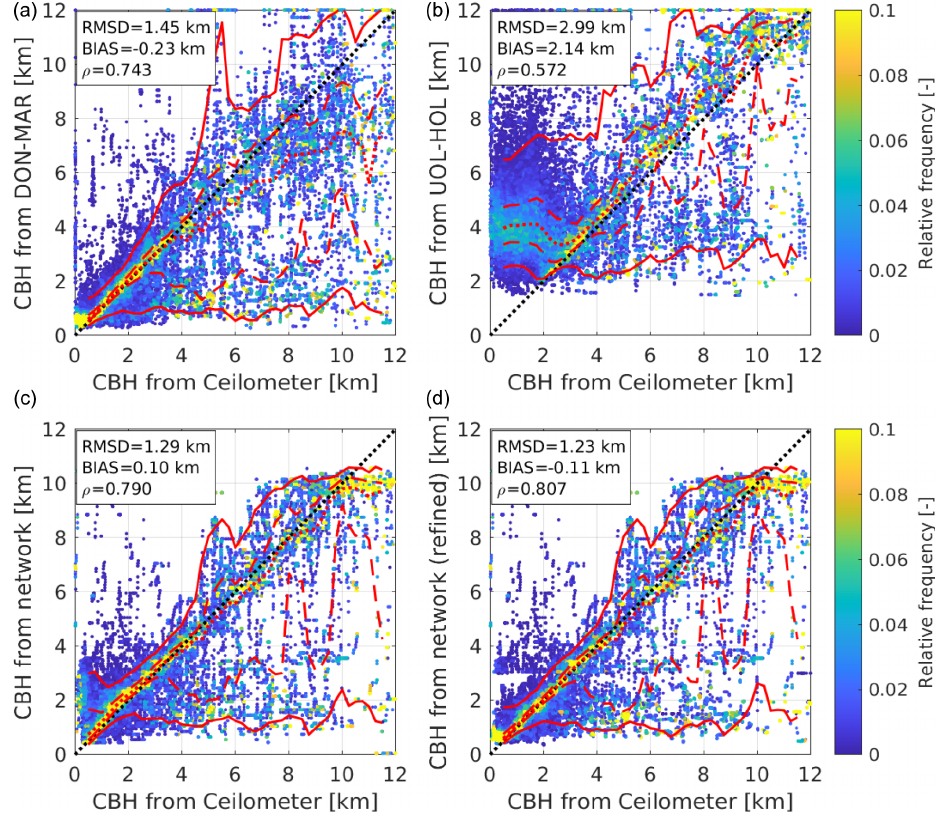
Figure 8. Relative frequency of ASI-based CBH estimation for a given CBH from the ceilometer. An evaluation of two of the ASI pairs, DON-MAR (a) and UOL-HOL (b) , with respective camera distances of 0 . 8 and 5 . 7km, and from the ASI network, without (c) and with refinements (d) , is shown. The relative frequency in each column adds up to one. Additionally, the median (50% quantile; red dotted), limits to the interquartile range (IQR; red dashed line) and 5th and 95th percentiles (red solid line), based on floating 1000m bins of the CBH from ceilometer, are